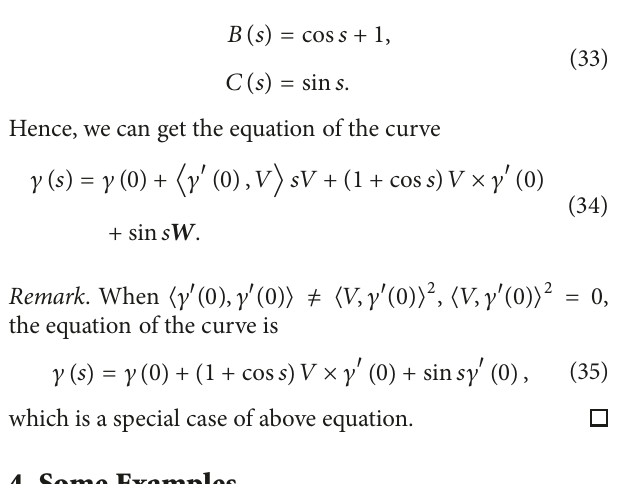
Figure 3: Red vector is 𝛾 󸀠 (0) = {1,−1, 0, −2} , and green vectors are magnetic fields 𝑉 = (1/2){1,1, 1,1}